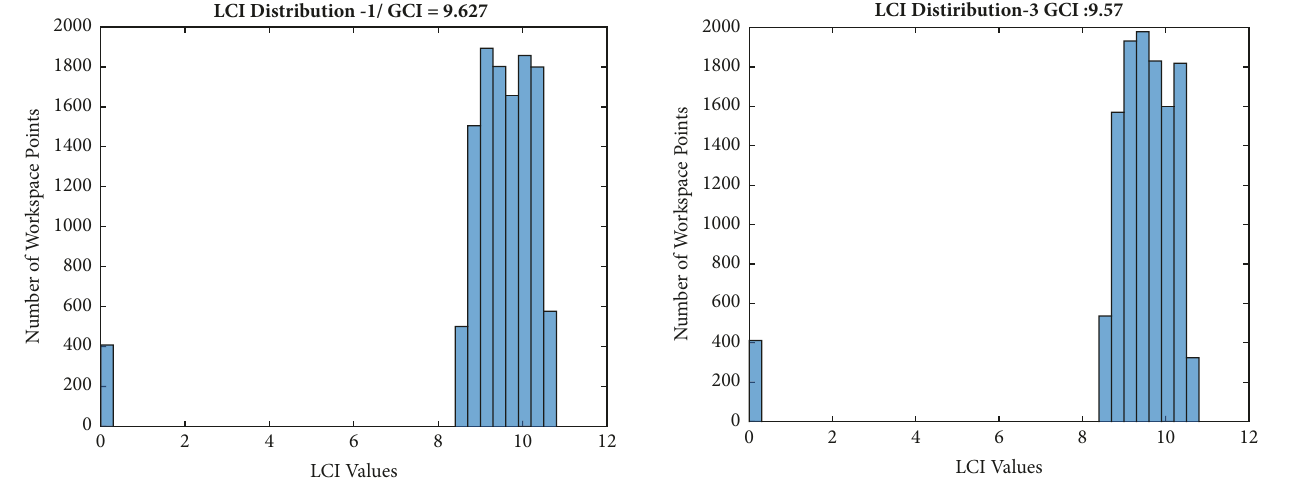
Figure 11: Distribution of LCI values based on un/reachable Figure 9: Distribution of LCI values based on un/reachable workspace points for three-parameter optimization, 𝑟 𝑏,𝑜𝑝𝑡 = workspace points for three-parameter optimization, 𝑟 𝑏,𝑜𝑝𝑡 = 0.128 [m], 𝑟 𝑝,𝑜𝑝𝑡 = 0.071[m], and 𝑙 𝑖 = 0.127[m], 𝑟 𝑝,𝑜𝑝𝑡 = 0.071[m], and 𝑙 𝑖 = 0.300-0.450[m]. LCI Distribution-2 GCI : 9.49